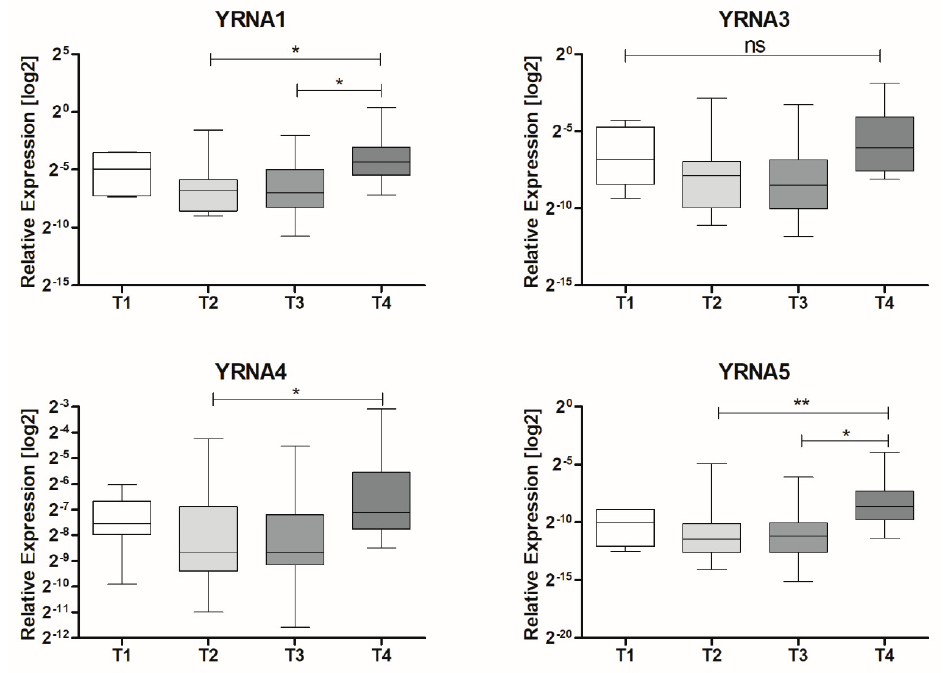
Figure 3. Expression levels of YRNA1, YRNA3, YRNA4, and YRNA5 in patients’ FFPET samples.